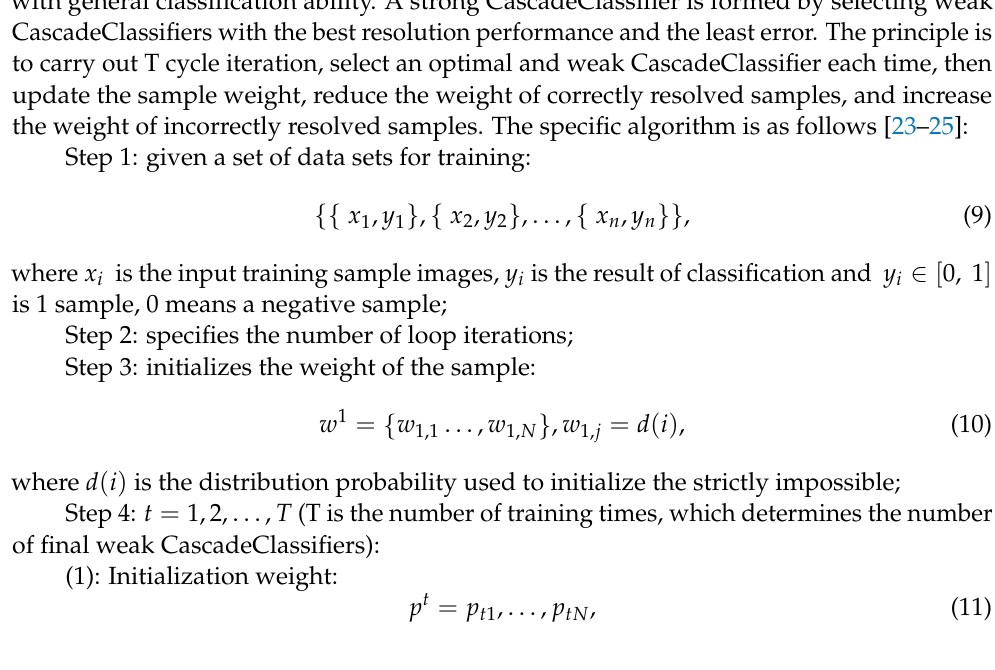
Figure 5. Negative Sample Picture.